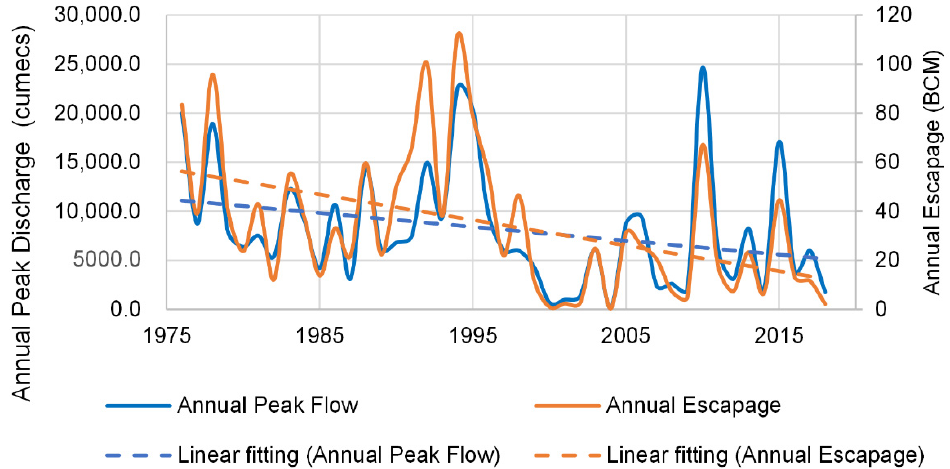
Figure 2. Temporal variation of annual peak discharge and annual escapage downstream of the Kotri barrage from 1976 to 2018.